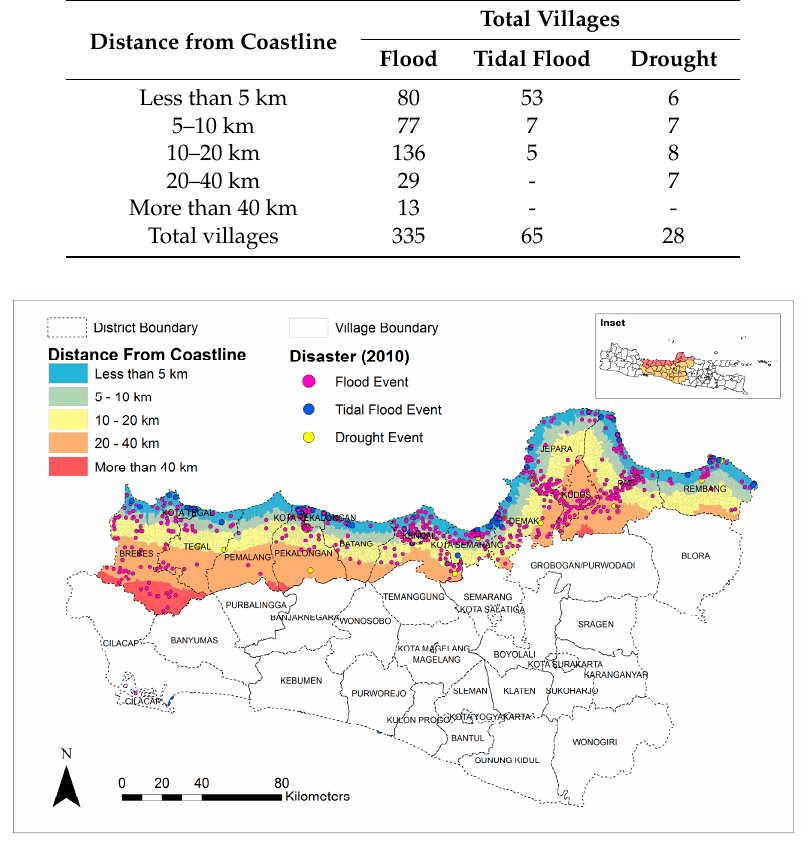
Figure 5. Distribution of different climate disasters in 2010.